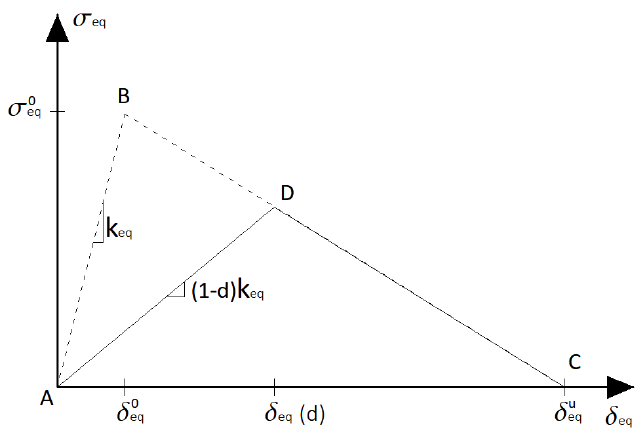
Figure 1. Constitutive relation for the equivalent stress and equivalent displacement.